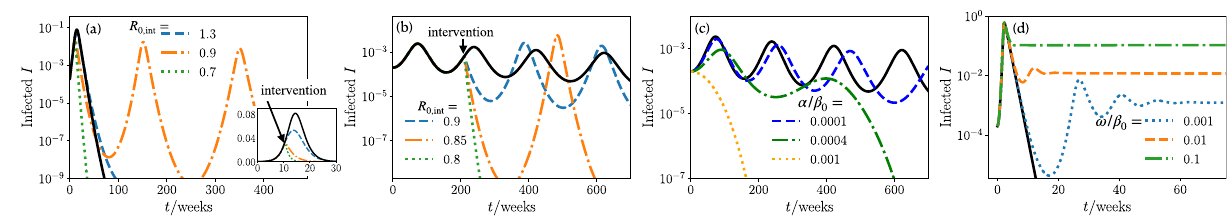
Figure 3. Nonpharmaceutical interventions, vaccinating, and immune escape. ( a ) Infections as function of time for a super exponential wave. Measures are taken by reducing the reproduction number to R 0,int at time t int . Inset: zoom in to the early time regime (black line has no interventions, weeks). ( b ) Infections as function of time for a wave like pandemic course. Measures are taken by reducing the reproduction number to R 0,int at time t int (black line has no interventions, R 0 weeks). ( c ) Infections as function of time of different vaccination rates α (black line has no vaccination, R 0 4 ). ( d ) Infections as function of time of different immune escape rates ω (black line 3 , I 2 10 10 µ/β 2 0 0 − − = × = 4 1.2 , µ/β 2 2 10 2 , I 0 has no immune escape, R 0 − 0 = = = ×